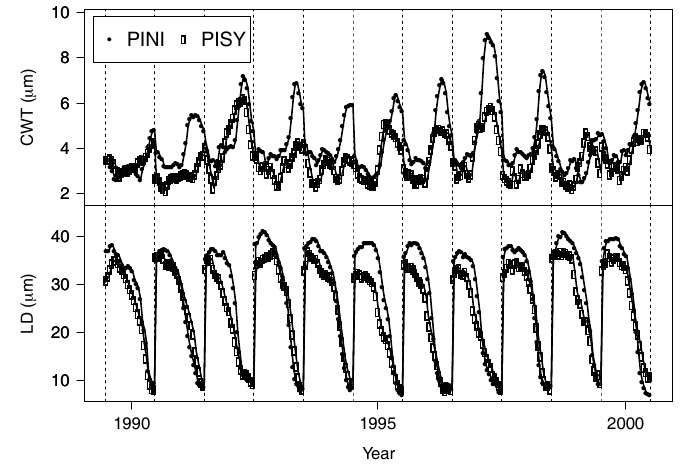
Figure 3. Cell wall thickness (CWT) and lumen diameter (LD) for the normalized tracheidogram of rings formed during the period 1990–2000. Each year represents the mean for 5 trees of each species.